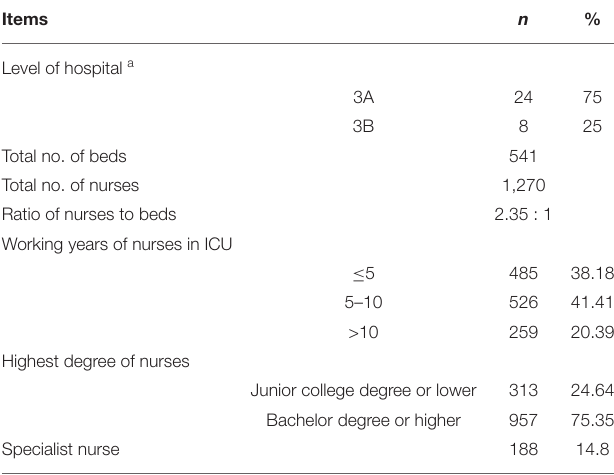
TABLE 1 | Information and demographic characteristics of the hospital.